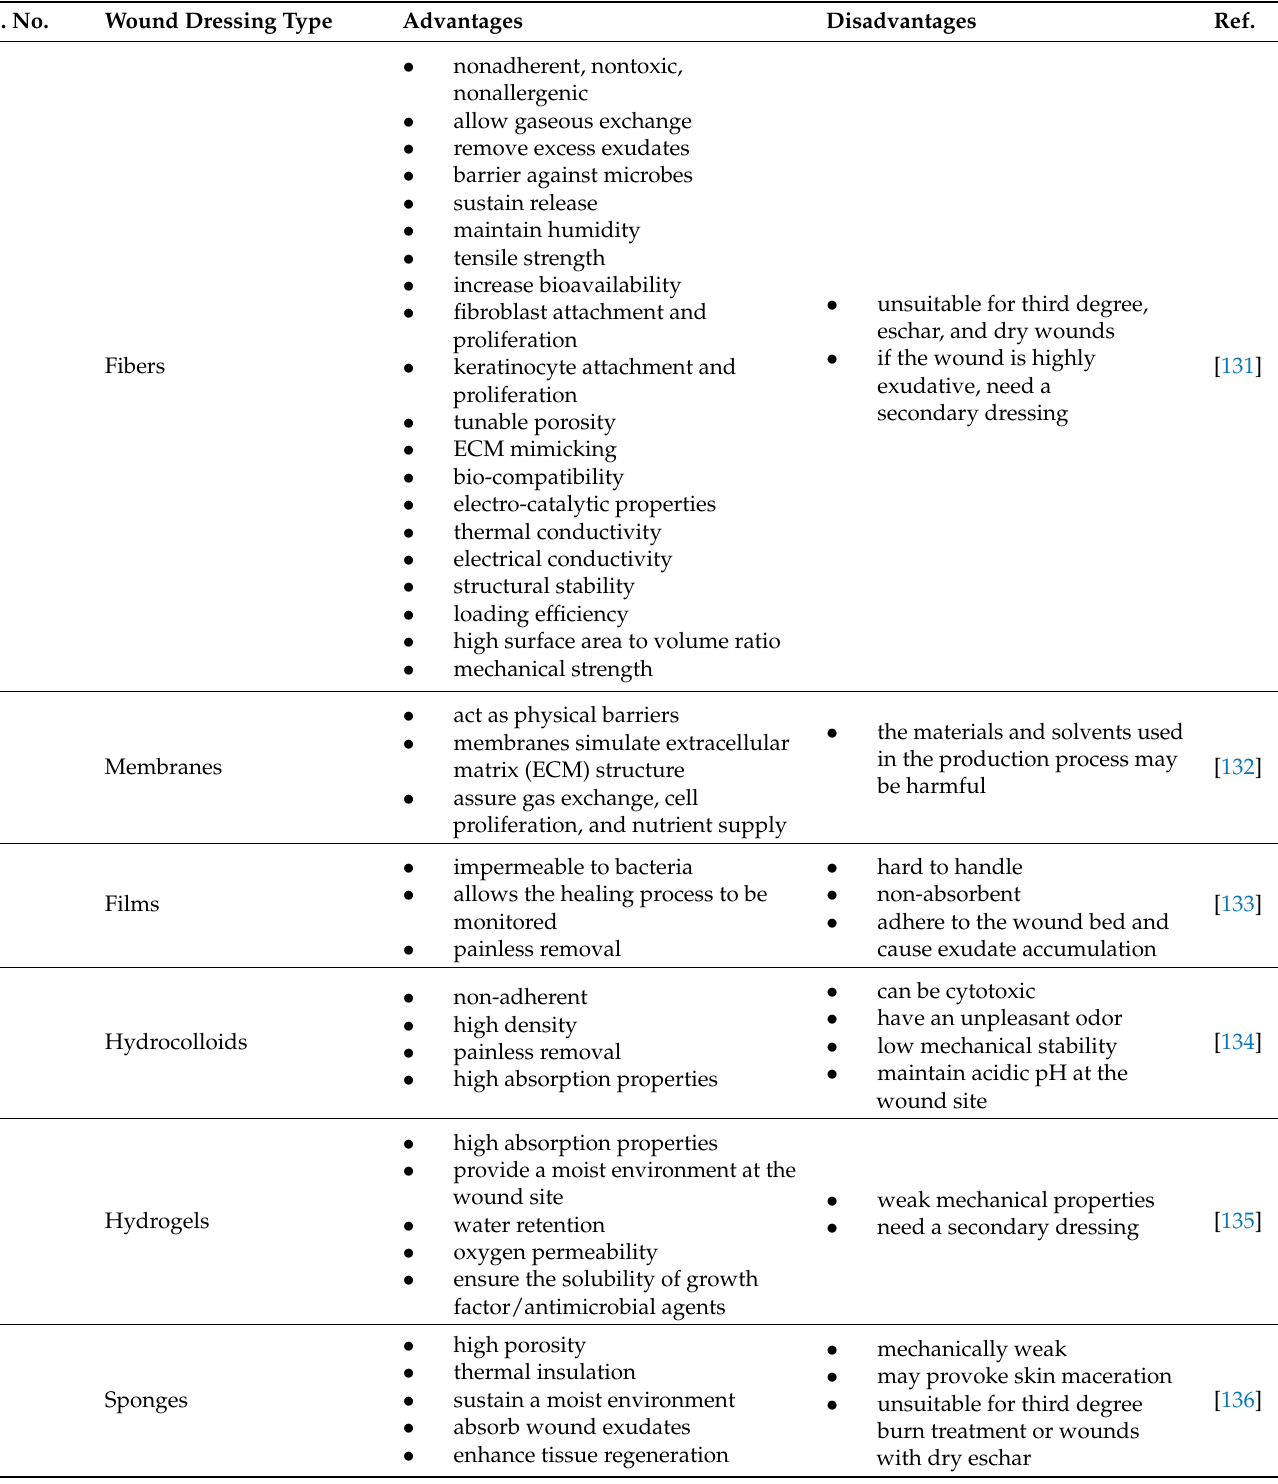
Table 2. The benefits and drawbacks of the various types of